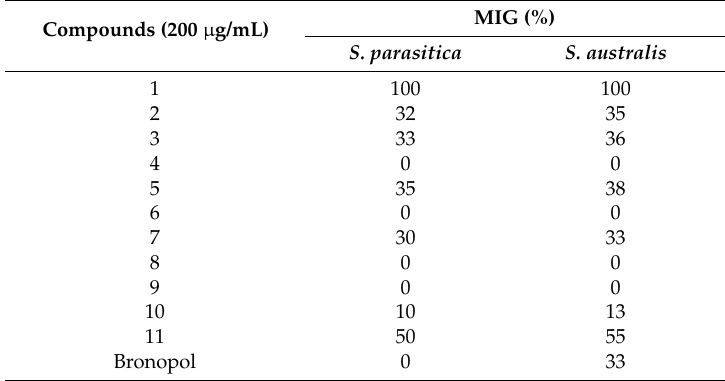
Table 3. Mycelial Growth Inhibition values of oxyalkylchalcones 1 – 11 against Saprolegnia spp. at 48